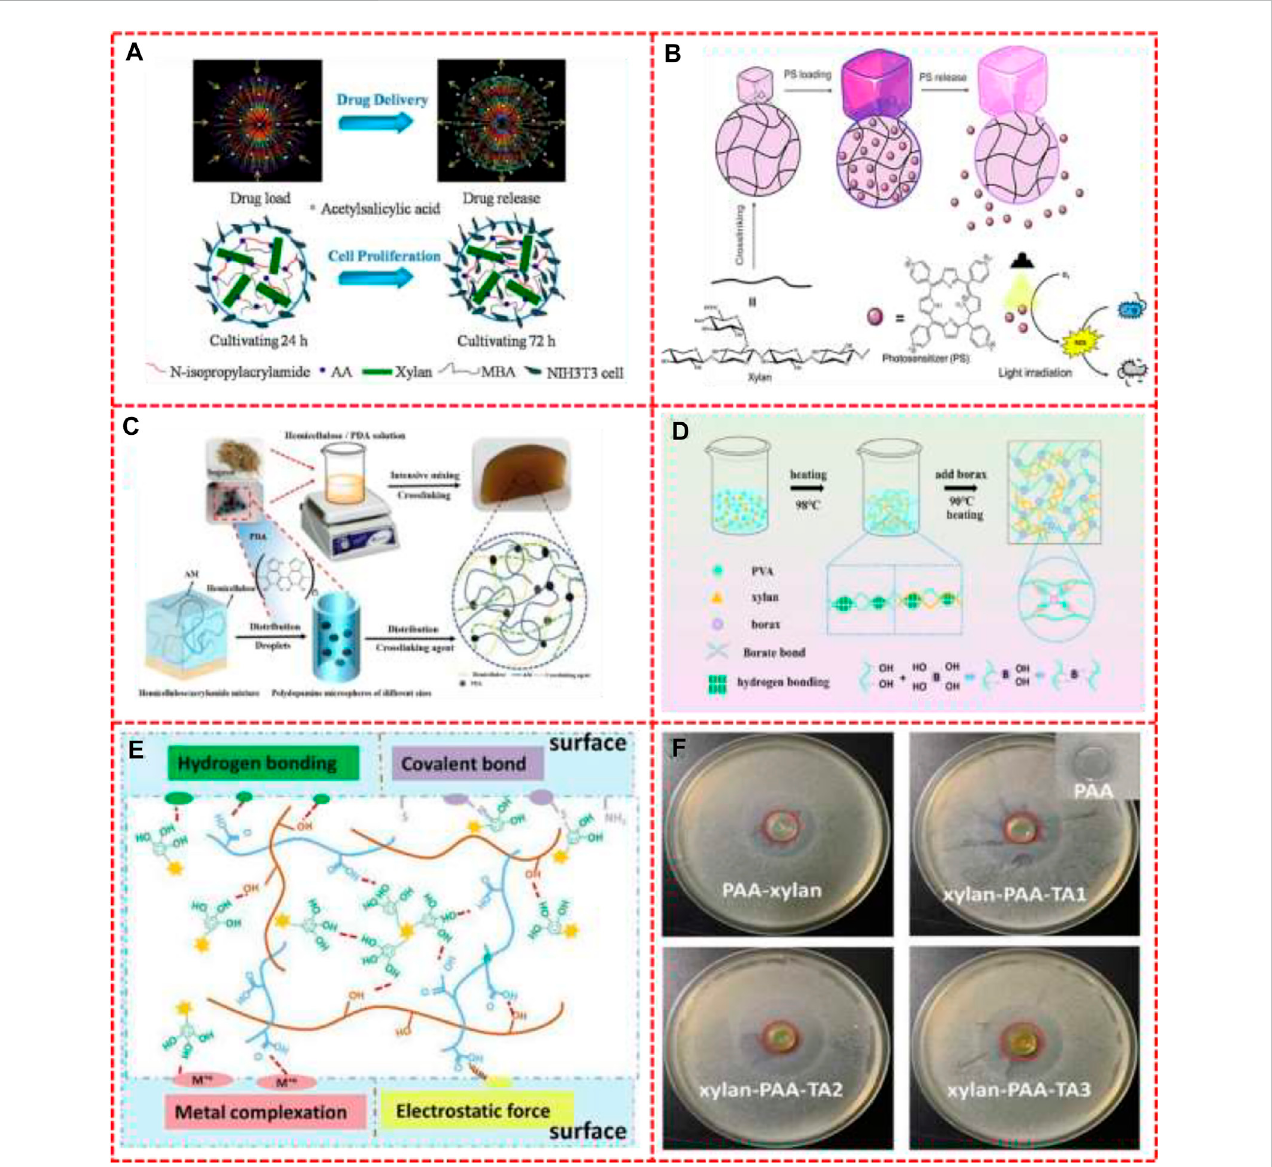
FIGURE 2 (A) The diagram of drug delivery behaviors and cell proliferation of the xylan-based P(NIPAm-g-AA) hydrogels copolymer networks, (B) The strategy of formation of hydrogels and photodynamic antimicrobial chemotherapy, (C) The synthetic route of hemicellulose/PDA hydrogel, (D) Schematic illustration of the preparation process of xylan/PVA/B DN hydrogel and possible reversible diol-borate ester bonds, (E) The adhesion mechanism of xylan-PAA-TA hydrogels, (F) Photographs of the inhibition zone of the PAA, PAA-xylan hydrogel, xylan-PAA-TA1, xylan-PAA-TA2 and xylan-PAA-TA3 hydrogels,